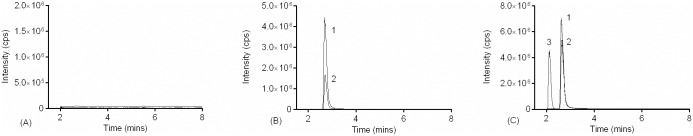
LC-MS/MS profiles of serum samples with BBR introduced in silico and in vivo.Chromatograms of (A) blank serum (B) blank serum spiked with (1) d6-BBR (31.25 ng/mL) and (2) BBR (7.8 ng/mL), and (C) serum from a Sprague-Dawley rat treated with 90 mg/kg BBR TD and collected 0.5 hours post administration demonstrating the presence of internal control (1) d6-BBR, (2) BBR, and the glucuronide metabolite (3) DMG.